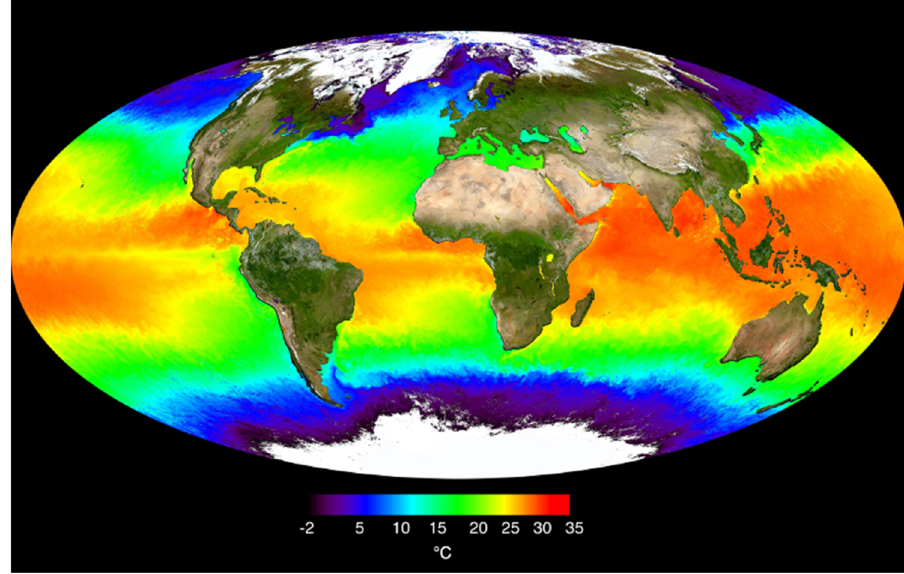
Figure 4: Sea surface temperature [ 30 ]